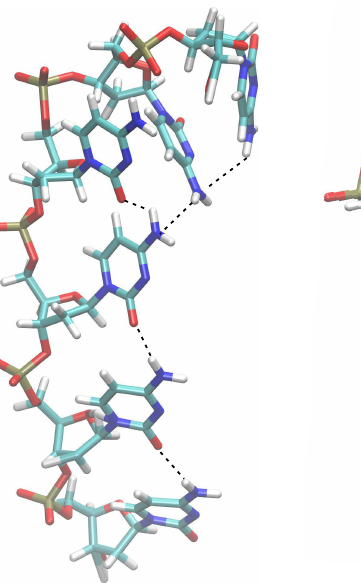
Figure 1. ( Left ) Irregular structure used as the starting geometry of ss-C 6 in MD simulations; dashed lines denote hydrogen bonds. ( Right ) Snapshot of a representative structure of ss-C 6 from MD trajectory; dashed lines indicate stacked